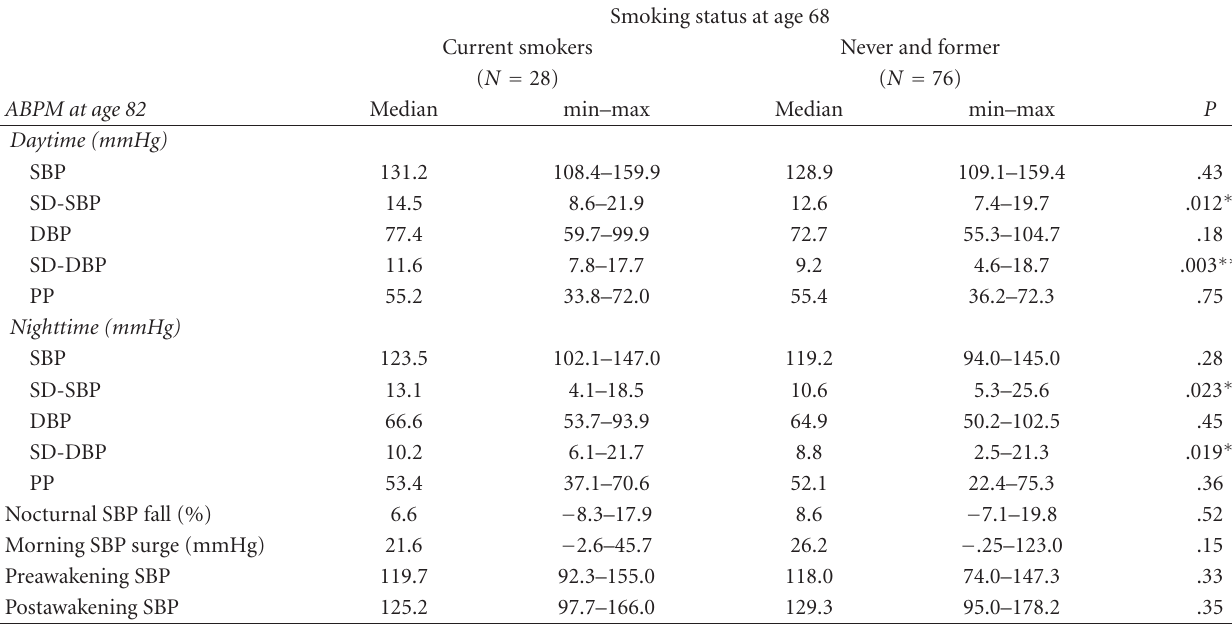
Table 4: Di ff erence in ambulatory blood pressure at age 82 between subjects defined as current and never/former smokers at age